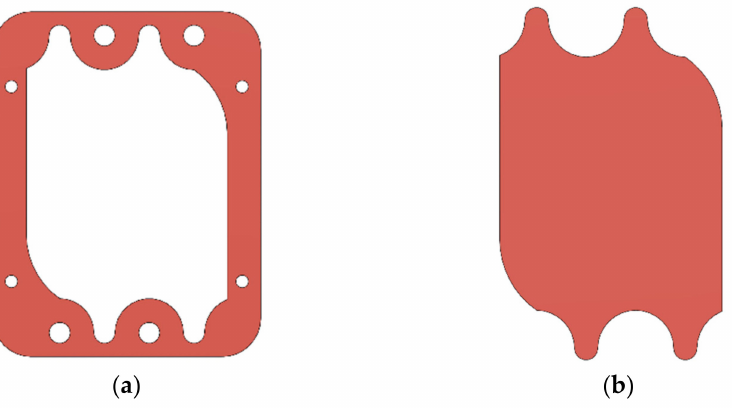
Figure 4. Spacer G2. ( a ) gasket of spacer G2; ( b ) total area of spacer